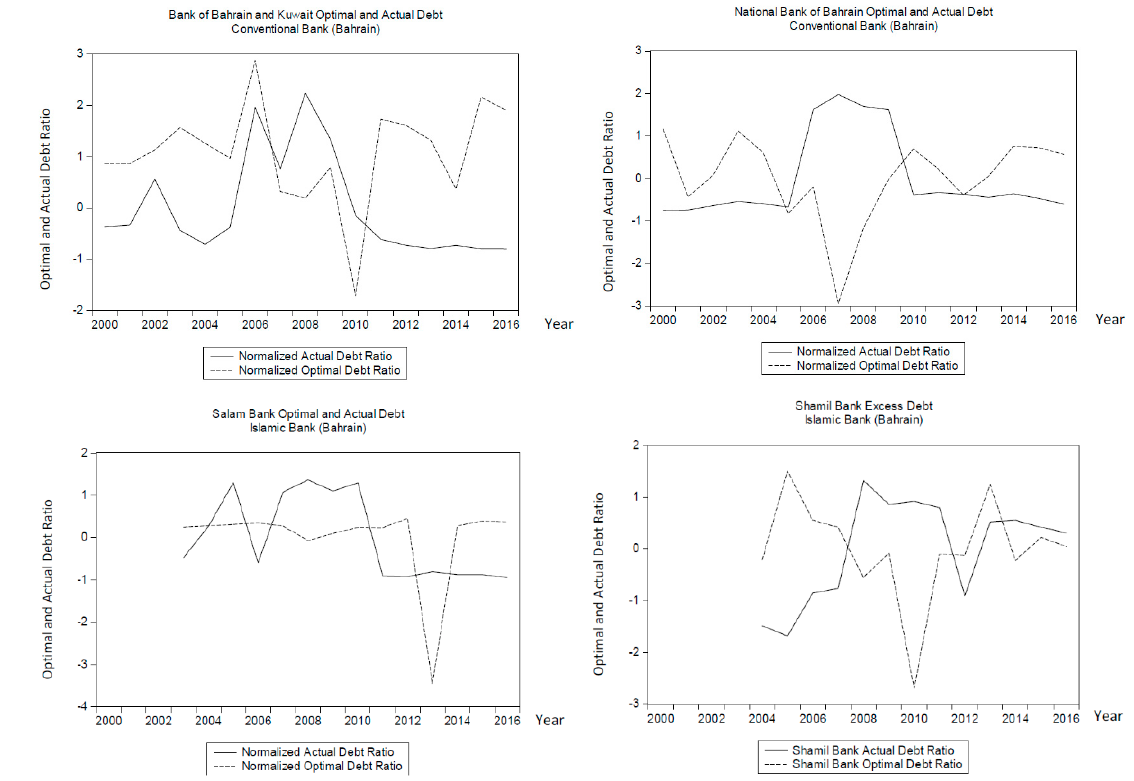
Figure 1. Bahrain optimal- versus actual-debt ratio. Source: Author’s calculations.